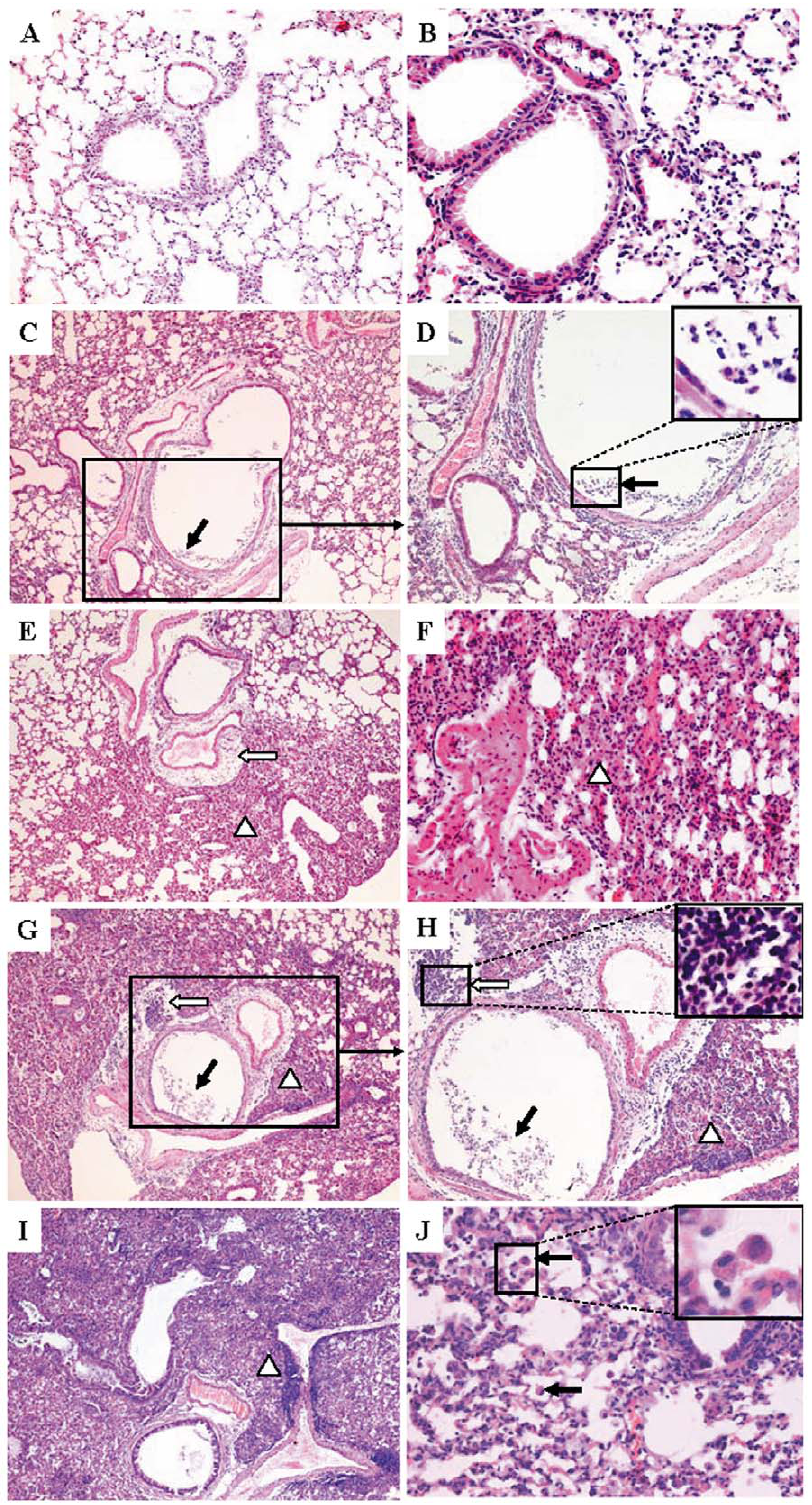
Figure 2. Hematoxylin-eosin stained sections from lung tissues of SD/09-infected mice. Normal mouse lungs (A, B). On day 4 p.i., dropout of mucous epithelium and inflammatory cells adhered to the surface of bronchioles (C, D, solid arrows). On day 6 p.i., severe edema around blood vessels (E, open arrows); dropout of alveolar epithelial, erythrocytes, and inflammatory cells within alveolar spaces (E, F, D ). On day 8 p.i., the virus caused more severe interstitial pneumonia (G, H, D ), bronchiolitis (G, H, solid arrows) and peribronchiolitis (G, H, open arrows). On day 14 p.i., the interstitial tissue was thickened with fibrin exudation and organization (I, D ). Lymphocytes and alveolar macrophages were the predominant inflammatory cells observed (J, solid arrows). Magnification: C, E, G, and I, 6 100; A, D and H, 6 200; B, F and J, 6 400. doi:10.1371/journal.pone.0029347.g002 PLoS ONE |